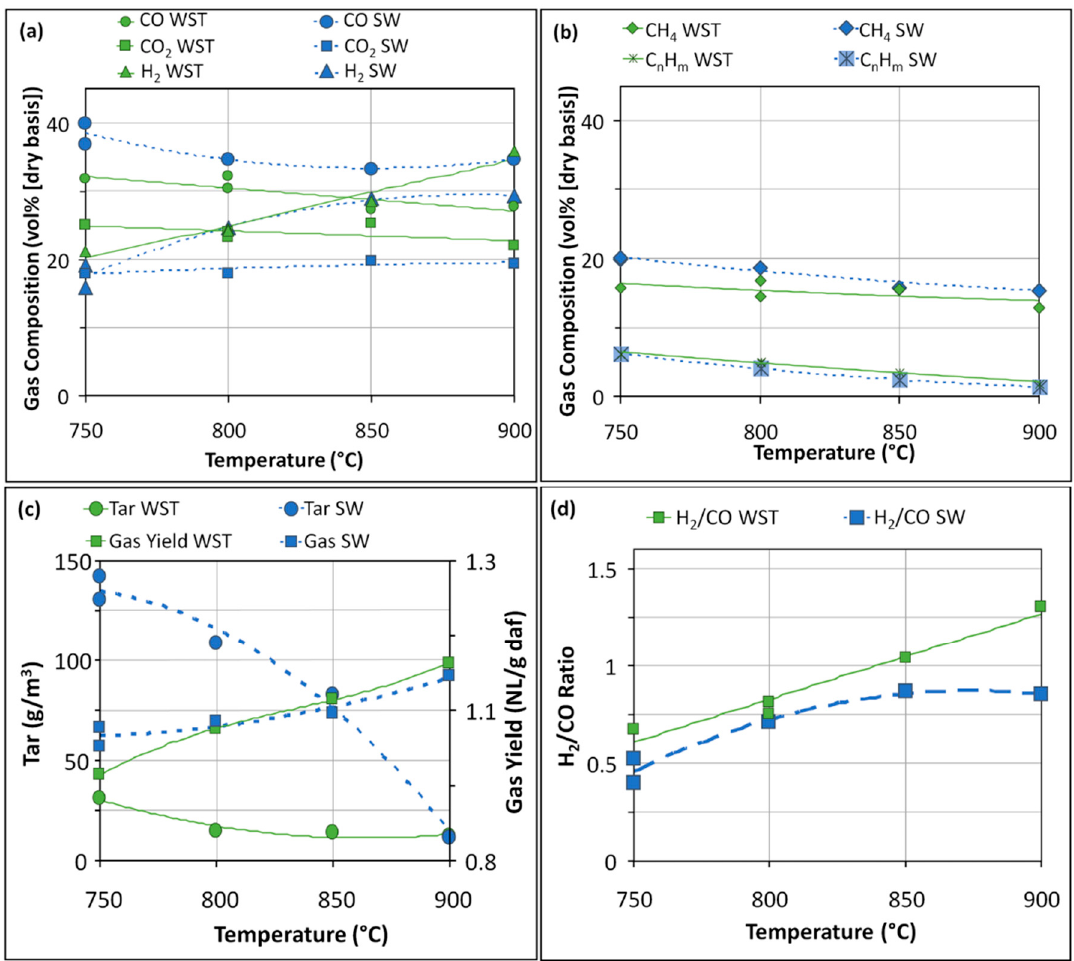
Figure 2. Effects of the temperature on CO, CO 2 , and H 2 compositions ( a ), CH 4 and C n H m compositions ( b ), tar and gas yield, ( c ) and H 2 /CO ratio ( d ) as obtained by the gasification of WST and SW with oxygen and steam (experimental conditions: ER = 0.13, steam/lignin = 0.35 g/g(daf)). NL, volume of syngas in L at standard conditions of temperature and pressure: 293.15 K, 1.0 × 10 5 Pa absolute pressure.